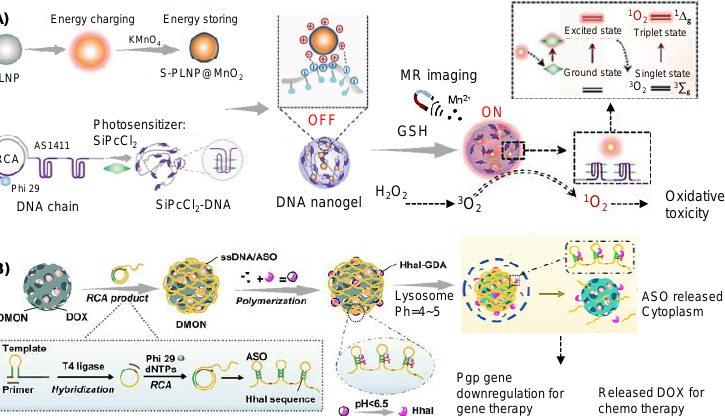
Figure 8. RCA technology-based hybrid DNA hydrogel for cancer therapy. ( A ) DNA hybrid nanogel for the PDT of breast cancer. Reproduced with permission. Copyright 2022, Wiley-VCH Verlag GmbH [57]. ( B ) The schematic of DNA hybrid nanogel (DMON/DOX-DNA/ASO-HhaI@GDA) for the chemo and gene cooperative therapy. Reproduced with permission. Copyright 2022 [58], the American Chemical Society.